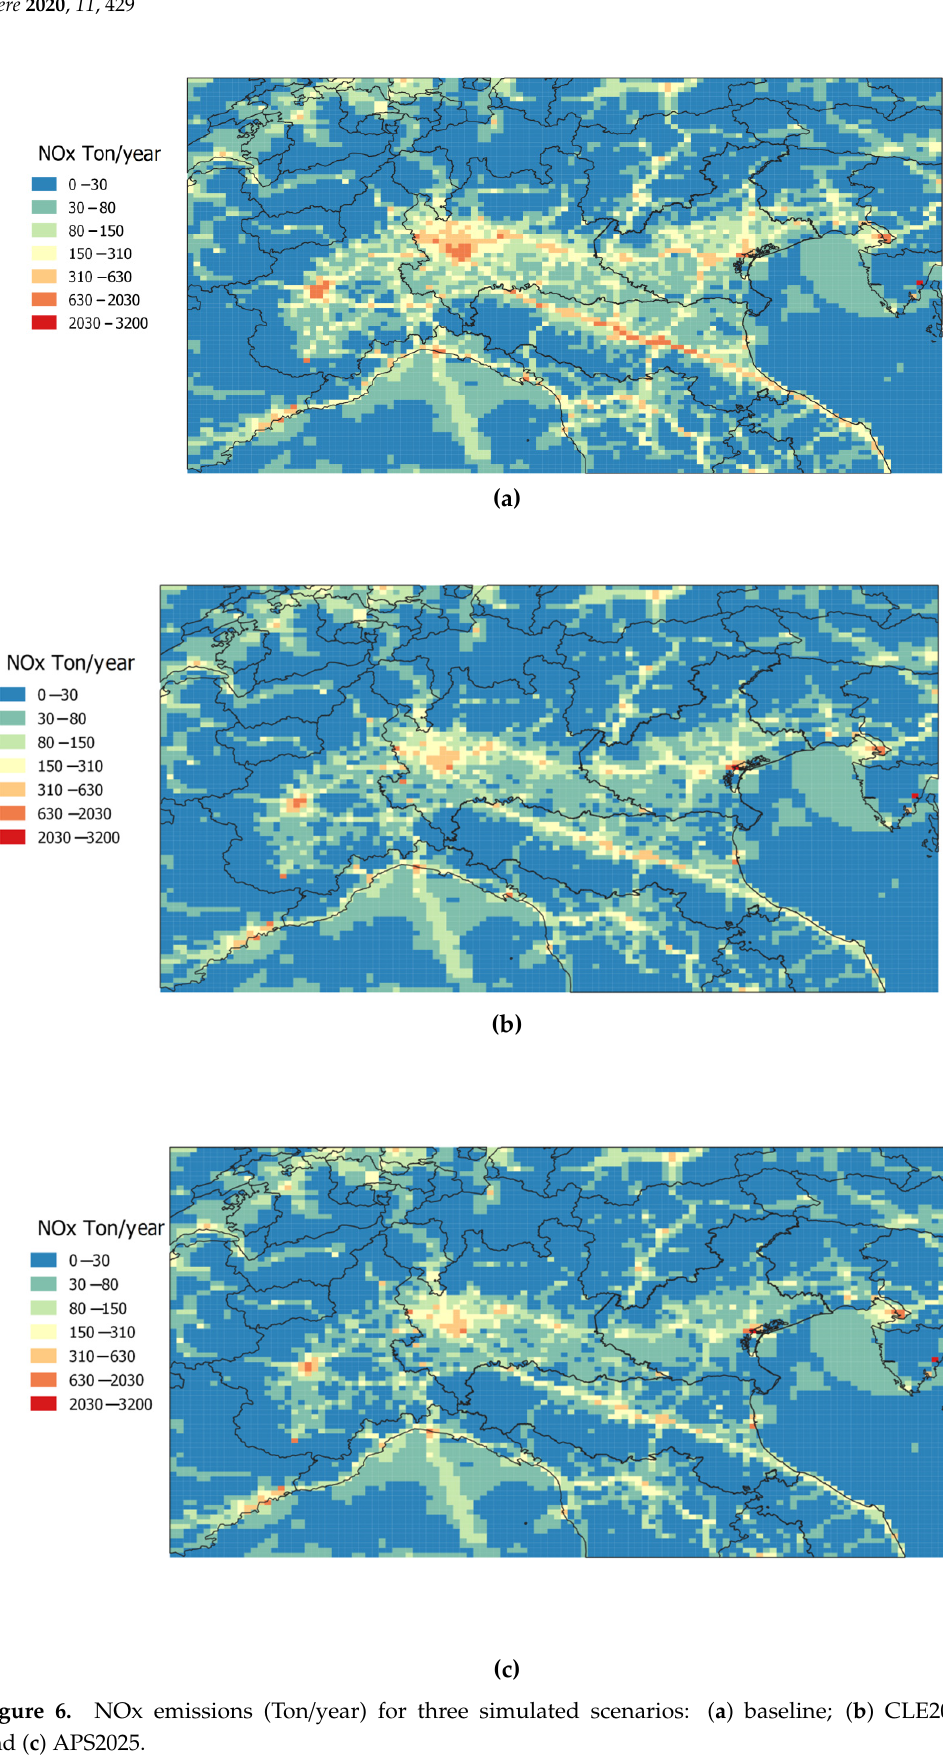
Figure 6. NOx emissions (Ton / year) for three simulated scenarios: ( a ) baseline; ( b ) CLE2025; and ( c ) APS2025.